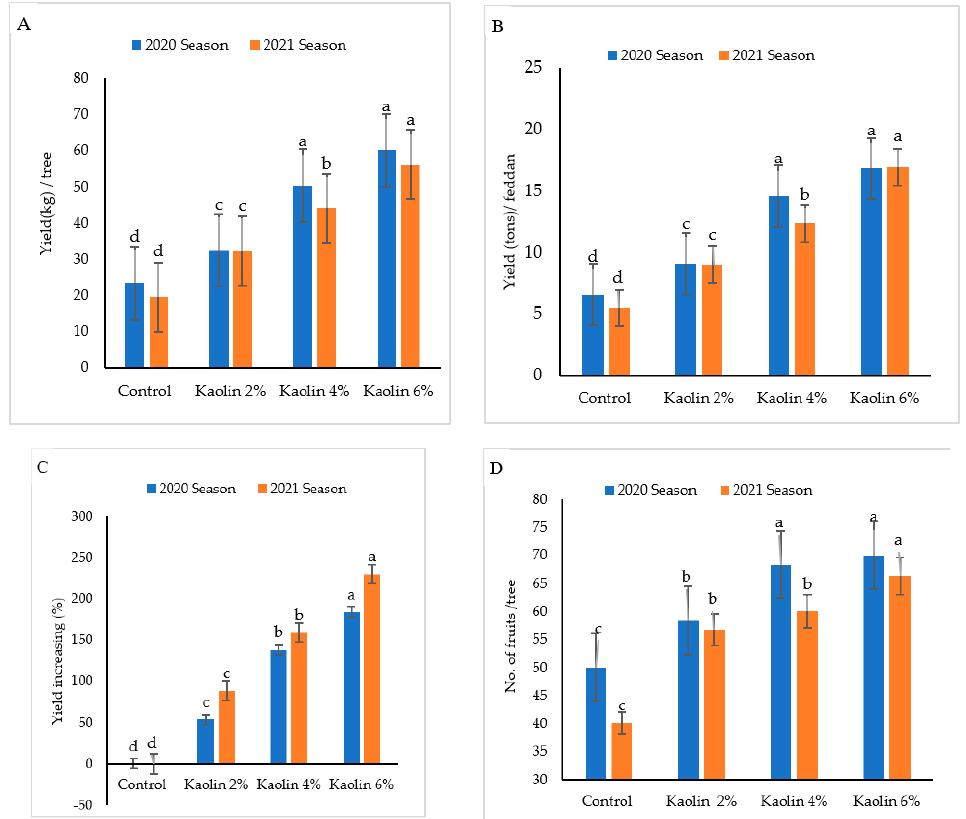
Figure 6. Effect of kaolin spray on: ( A ) tree yield (Kg/tree), ( B ) tree yield (tons/feddan), ( C ) tree yield increasing (%) and ( D ) No. of fruits per tree of Keitt mango cultivar during the seasons 2020 and 2021. Bars indicate mean values ± SE (n = 9). Different letters above columns indicate significant differences among pruning treatments at p = 0.05 according to Bartlett’s test.